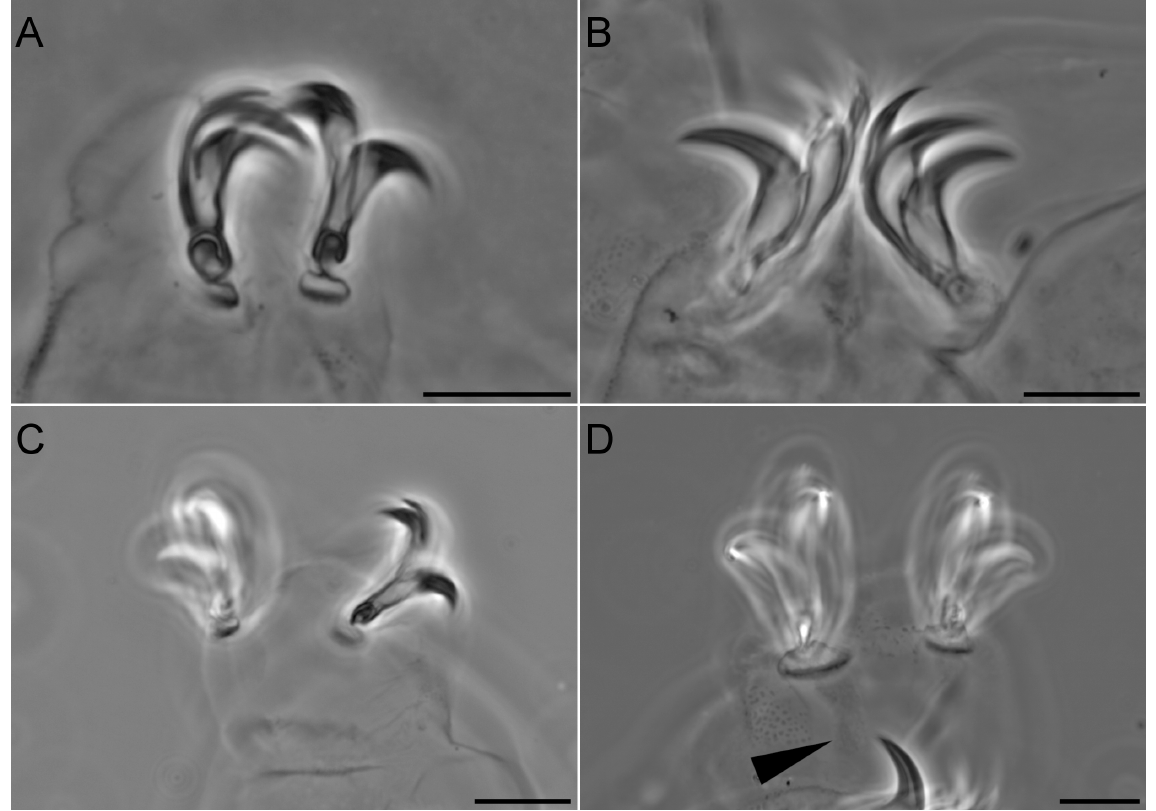
Fig. 3. Sisubiotus hakaiensis sp. nov., claws in PCM. A * , C . Paratype (JYUt.S1911_SL3_A). Claws II– III. B, D . Holotype (JYUt.S1911_SL5_B). Claws IV. Arrowhead indicates horseshoe-shaped